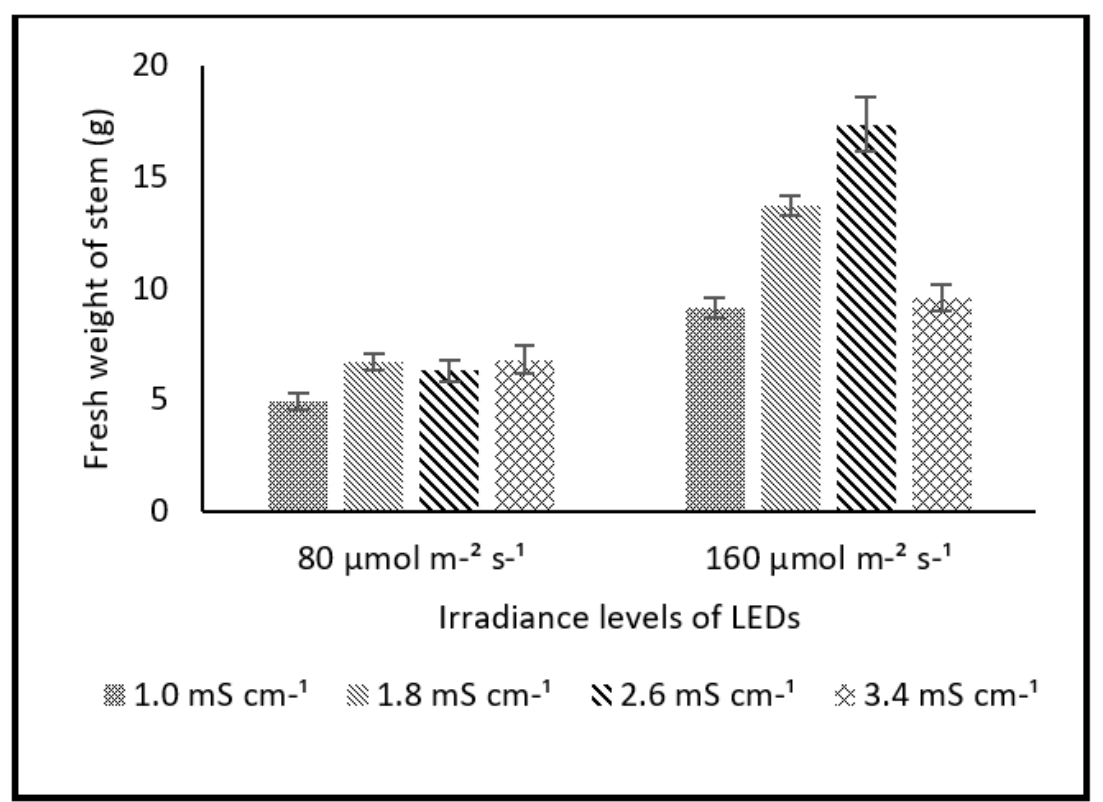
Figure 4. Interaction effect of LED irradiance levels and nutrient solution EC on fresh stem weight of lemon basil.